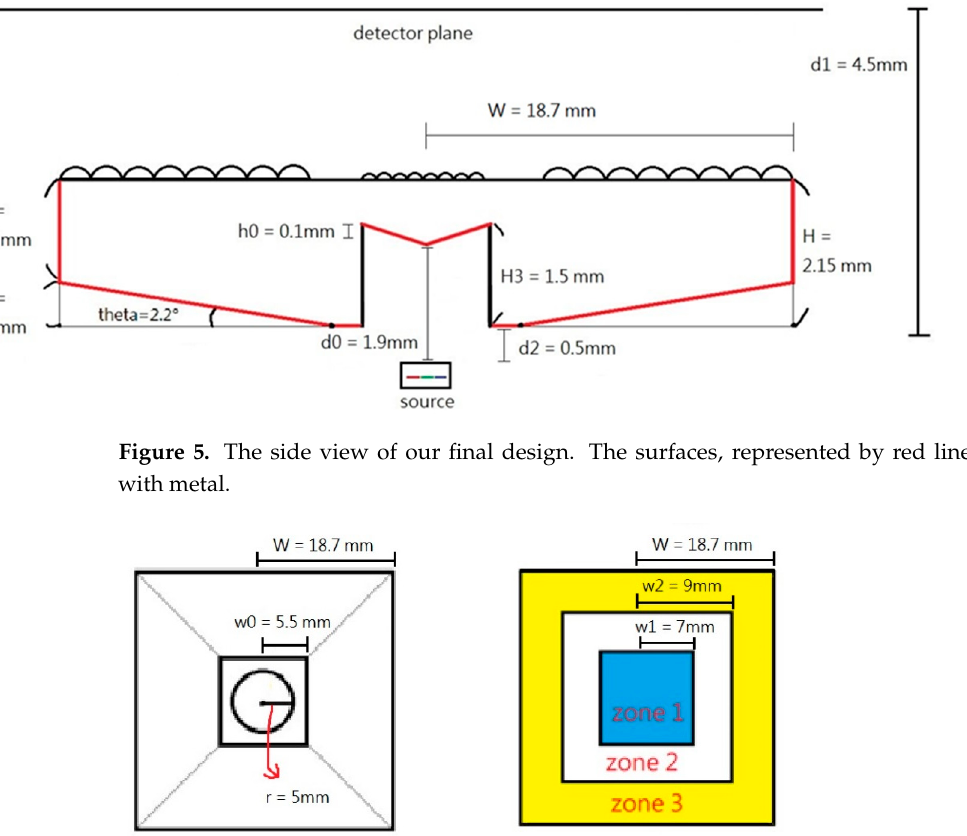
Figure 4. The relationship between the tilted angle of the back mirror and the power efficiency.